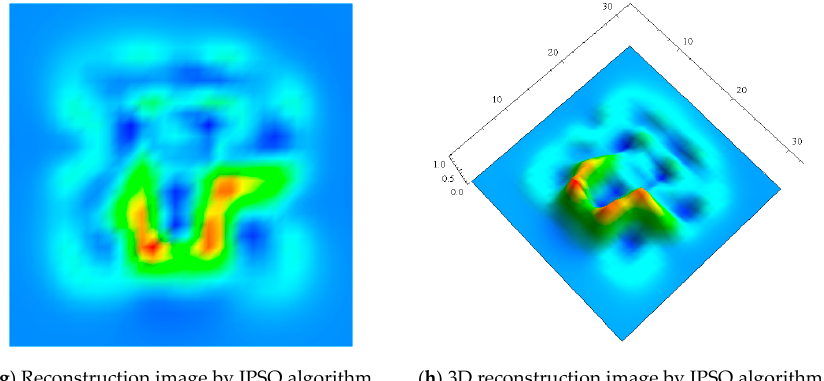
Figure 9. Images reconstructed by different algorithms for Sample 2.